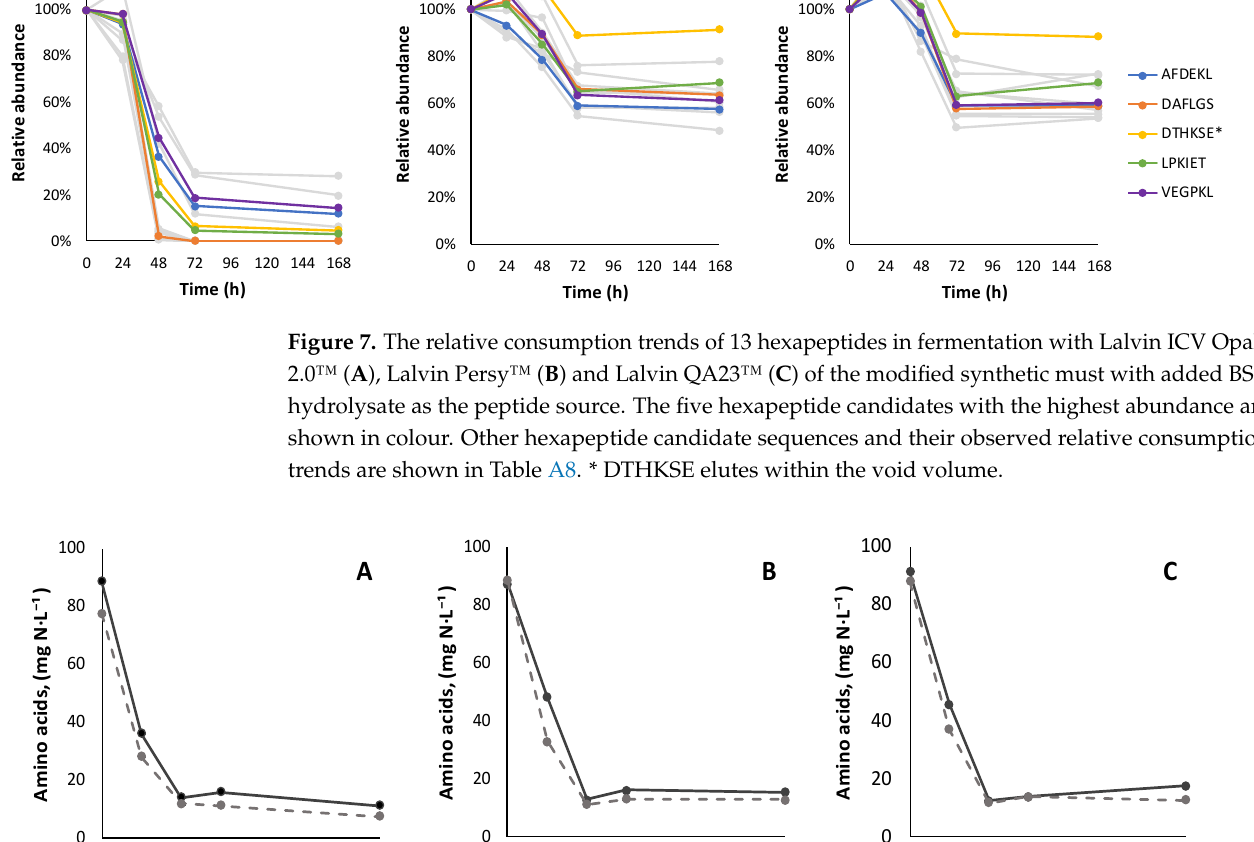
10 of 22 Figure 6. The relative consumption trends of 19 pentapeptides in fermentation with Lalvin ICV